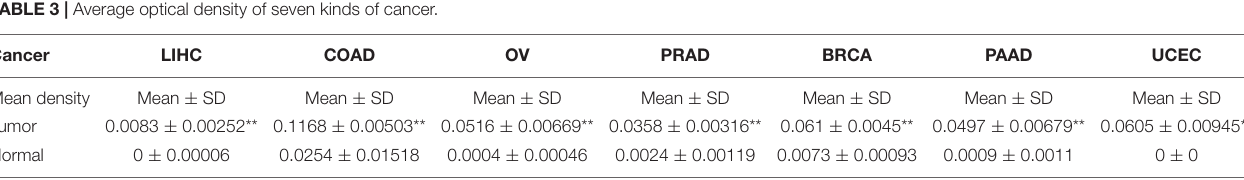
FIGURE 7 | HPA database verifies the expression of TLR4 gene in seven tumors. The expression of TLR4 gene in LIHC (A) , COAD (B) , OV (C) , PRAD (D) , BRCA (E) , PAAD (F) , and UCEC (G) is significantly higher than that in the corresponding normal tissues. TABLE 3 | Average optical density of seven kinds of